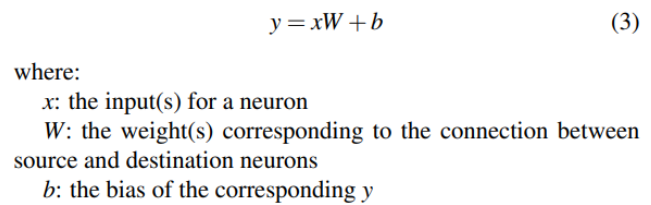
Fig. 2 Convolutional operation